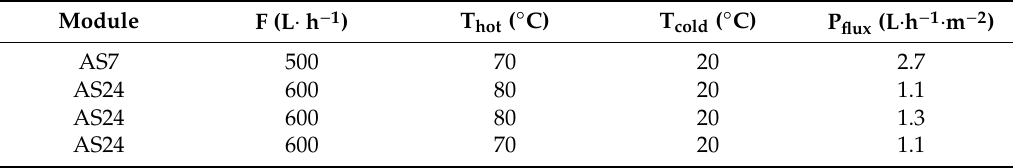
Figure 4. Permeate conductivity and SRF in an operation day with the AS7 module (blue squares and blue empty squares respectively) and the AS24 module (red circles and red empty circles respectively) both in AGMD configuration. Table 4. Permeate production with the operating conditions of the cases shown in Figure